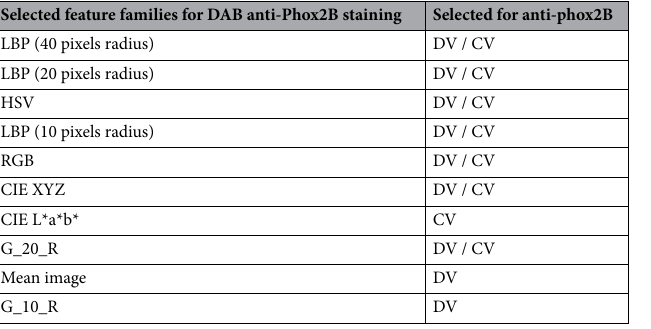
Table 4. Summary of the selected families for DAB anti-Phox2B. The feature families are ranked through their relevance (more precision in Supplementary Fig. 3 to 4). The nomenclature is presented in Material and Methods.